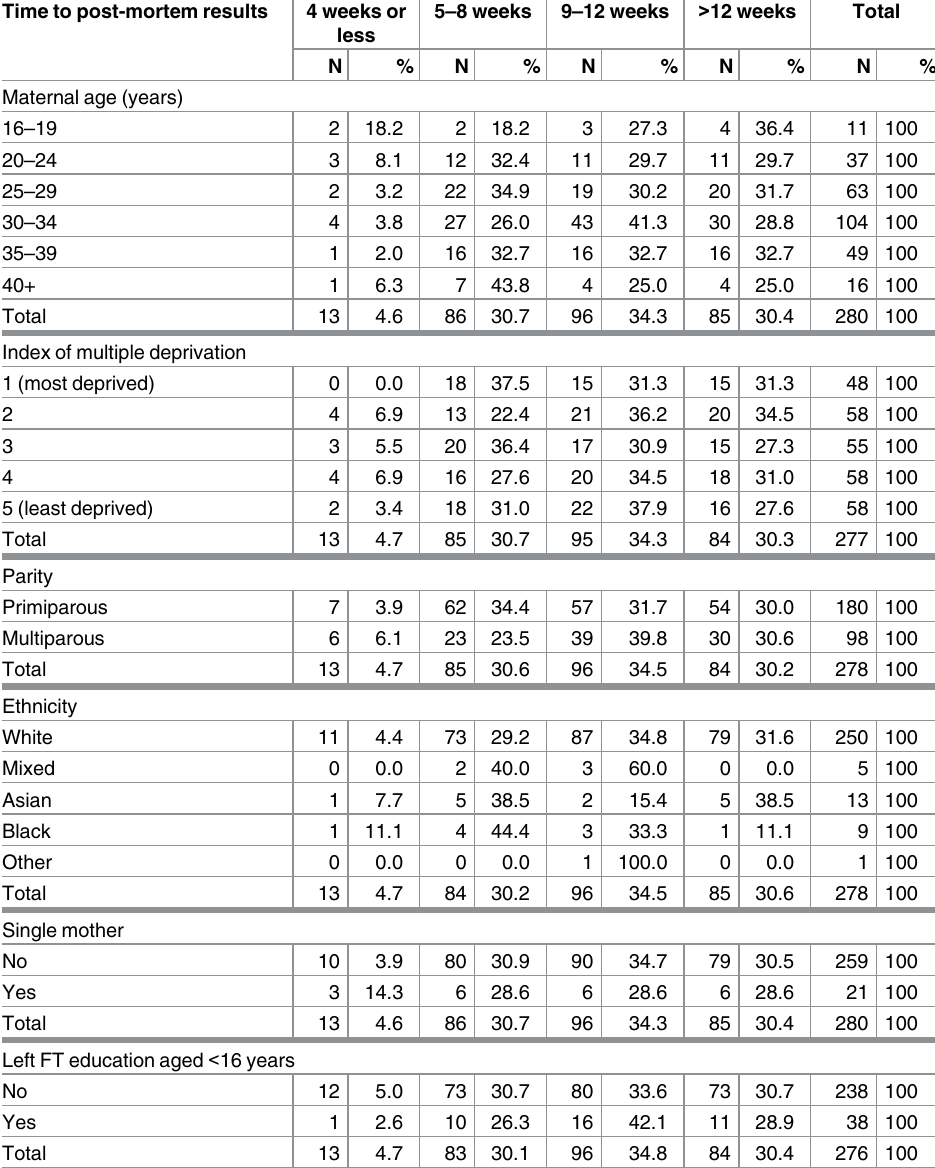
Table 5. How long women had to wait for post-mortem results by sociodemographic factors. Time to post-mortem